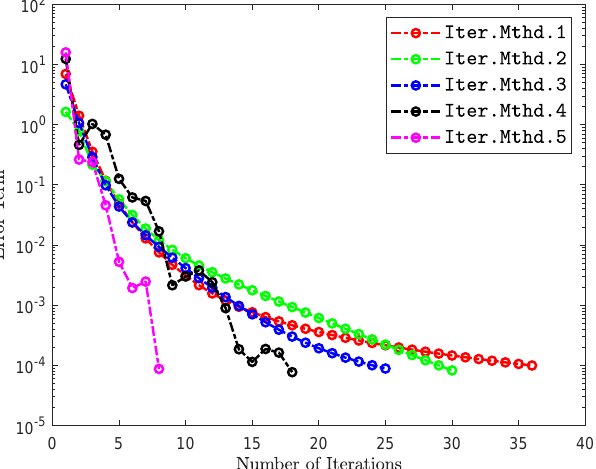
Figure 3. All techniques are computationally examined while s 0 = ( 1,2,1,2,3 ) T .